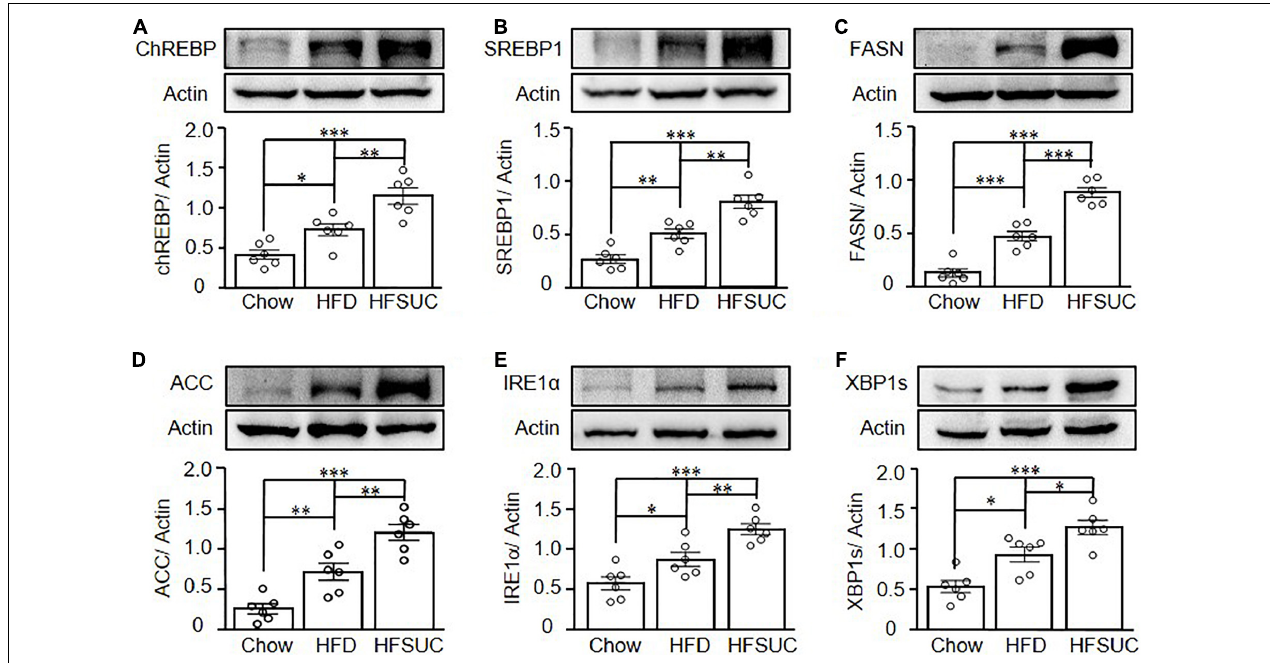
FIGURE 3 | Sucralose increased hepatic ER stress- and lipogenesis-related protein expressions in mice. Eight-week-old C57BL/6 mice were fed with a chow diet (Chow), high-fat diet (HFD), or HFD supplemented with sucralose (HFSUC) for 12 weeks. At the end of the experiments, each group of the mice was sacrificed and the liver tissues were removed. Western blots analysis was used to analyze the hepatic expressions of lipogenesis-related proteins, carbohydrate-response element-binding protein (ChREBP) (A) , sterol regulatory element-binding protein 1 (SREBP1) (B) , fatty acid synthase (FASN) (C) , and acetyl-CoA carboxylase 1 (ACC1) (D) , and ER stress-related proteins, IRE1 α (E) , and XBP1s (F) . Data are mean ± SEM ( n = 6 for each group) ∗ p < 0.05, ∗∗ p < 0.01, ∗∗∗ p < 0.001 as compared with indicated